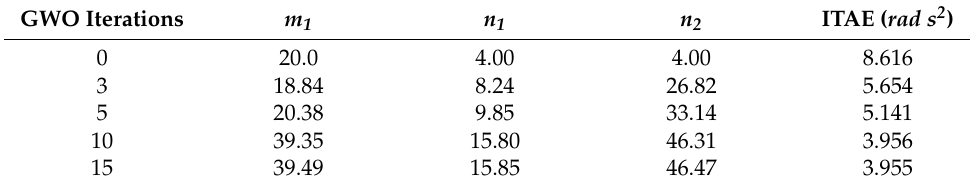
Table 2. GWO controller performance in term of